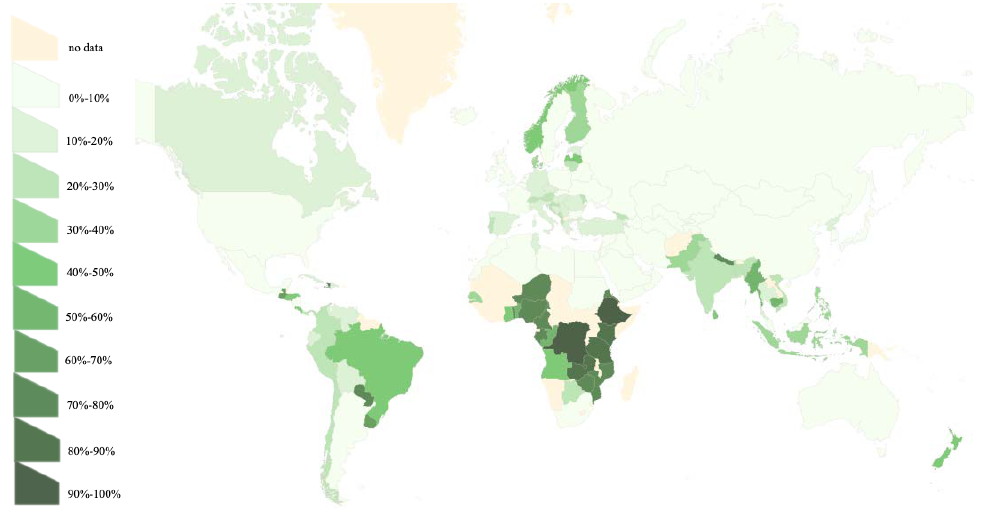
Figure 9. Renewable energy 2017 (as a % of primary energy supply) (Source: OECD).